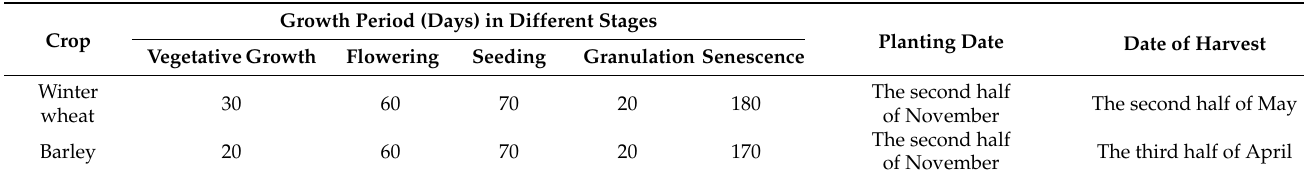
Table 1. Growth period duration and the planting/growing dates of the crop.